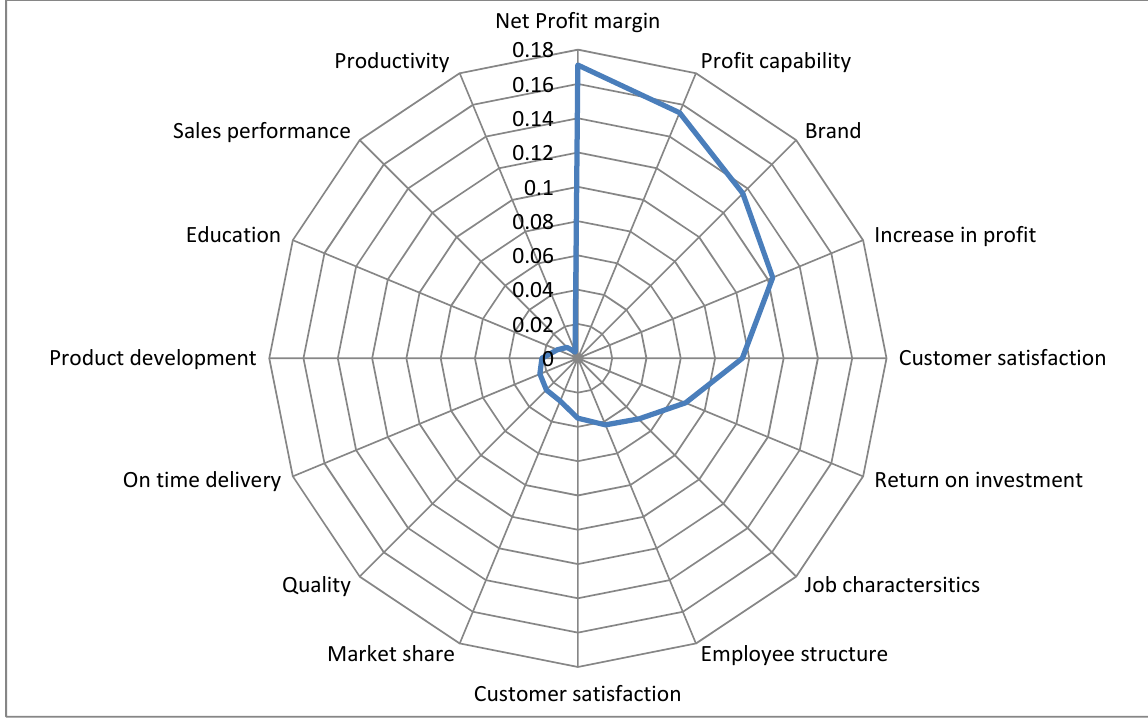
Fig. 5. The summary of the ranking of different BSC